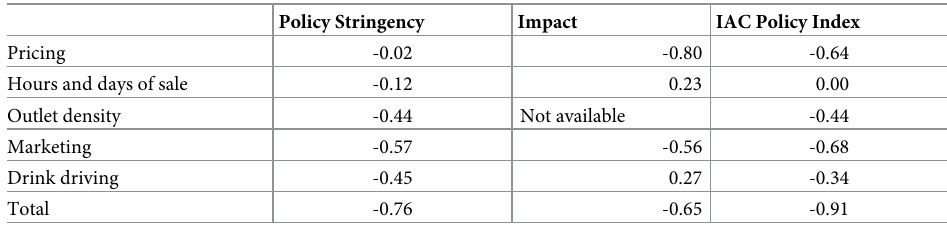
Table 3. Correlation with recorded APC (litres of pure